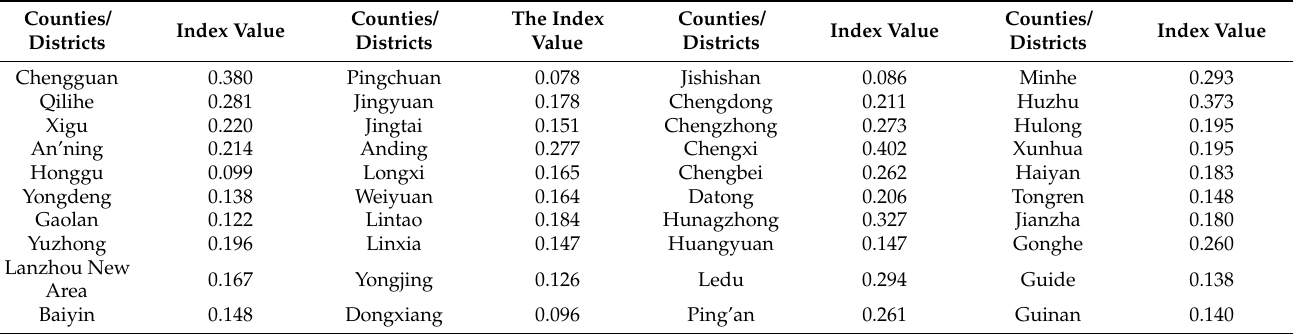
Table 4. Comprehensive index value of